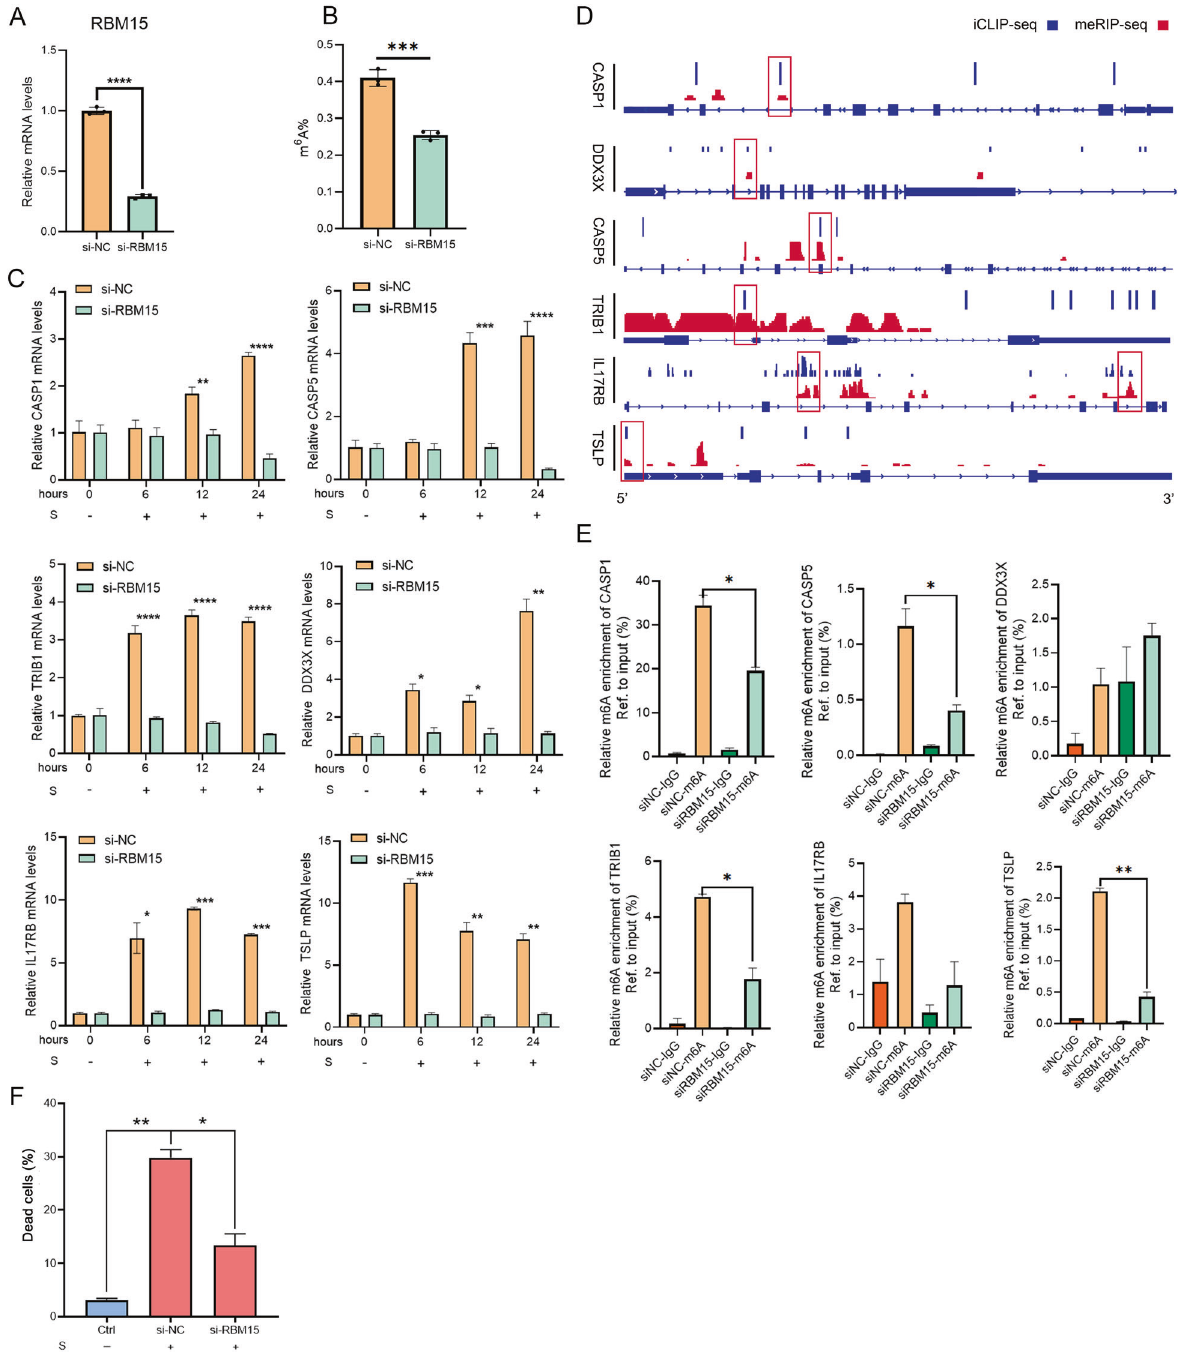
Fig. 4 RBM15 promoted the expression of functional genes by elevating m6A modi fi cation. HuT 78 cells transfected with either control siRNA (NC) or siRBM15 were cultured. mRNA expression level of RBM15 ( A ) was detected by qRT-PCR and total methylation level ( B ) was detected using a methylation quanti fi cation kit. C HuT 78 cells co-cultured with activated THP-1 cells transfected with either control siRNA (NC) or siRBM15 were treated with S protein for 0, 6, 12, and 24 h. CASP5, CASP1, and TRIB1 expression levels were detected using qRT-PCR. D Analyses of iCLIP-seq data and MeRIP-seq Data were plotted by the IVG. m6A abundance on CASP1, CASP5, DDX3X, IL17RB, TRIB1, and TSLP were aligned to the corresponding reference genome (blue color below fi gure). Blue colors (In the above) show the m6A signals of iCLIP-seq data, whereas red stands for MeRIP-seq data. At the same position, m6A peaks of iCLIP-seq group overlap MeRIP-seq group were recognized as the genuine m6A location. The most remarkable locations were highlighted with a Red block. E m6A modi fi cation of CASP1, CASP5, DDX3X, IL17RB, TRIB1, and TSLP were detected by MeRIP-qPCR analysis. Relative m6A enrichment of these genes for each IP group was normalized to input (%). Data were shown as means ± SD ( n = 3, * P < 0.05, ** P < 0.01, *** P < 0.001, and **** P <